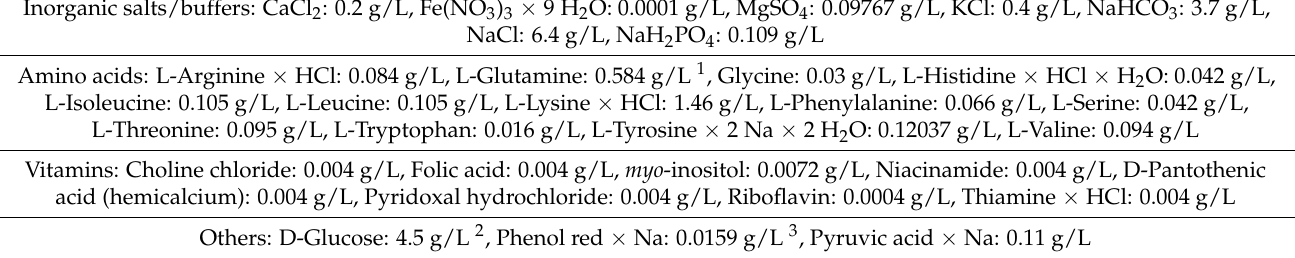
Table 1. Formulation of a Dulbecco’s modified Eagle medium (DMEM) with high